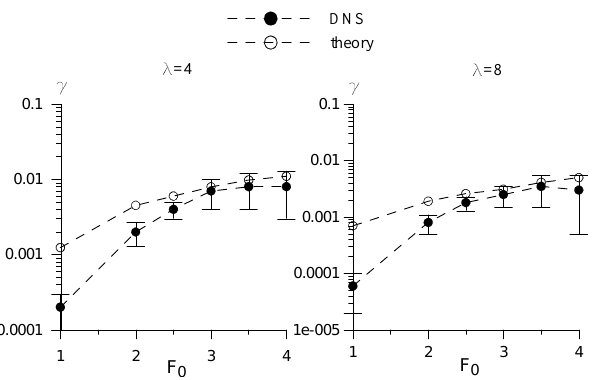
Fig. 9. The IW damping rate obtained in DNS and analytical prediction in Eq. (20) (open symbols) for IW wavelengths λ = 4 (left) and λ = 8 (right) for different forcing amplitudes.